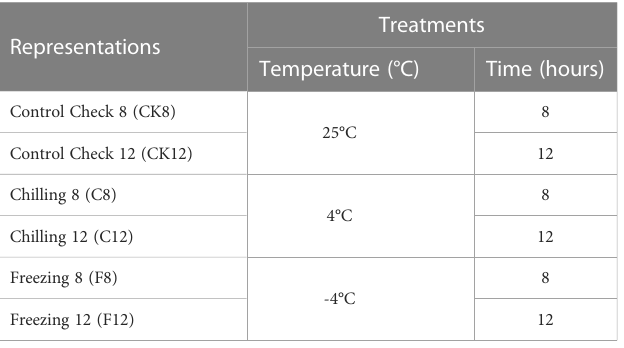
TABLE 1 Treatment settings of low temperature